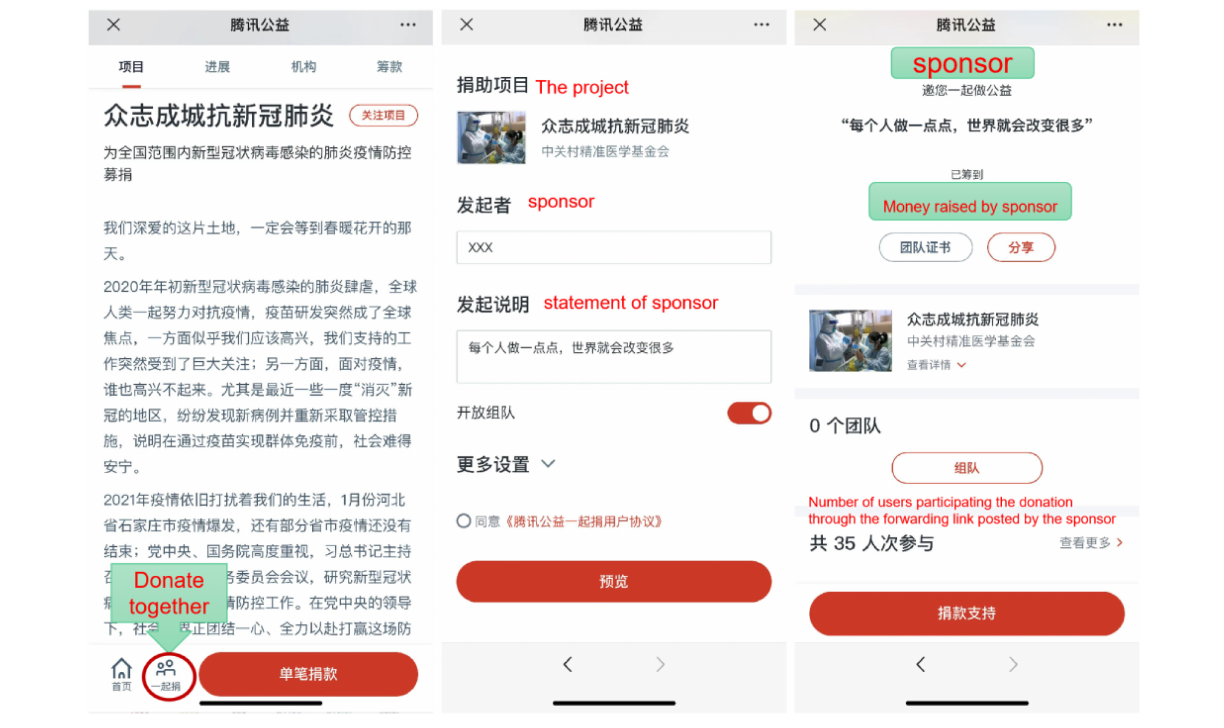
FIGURE 3 | The function of “donate